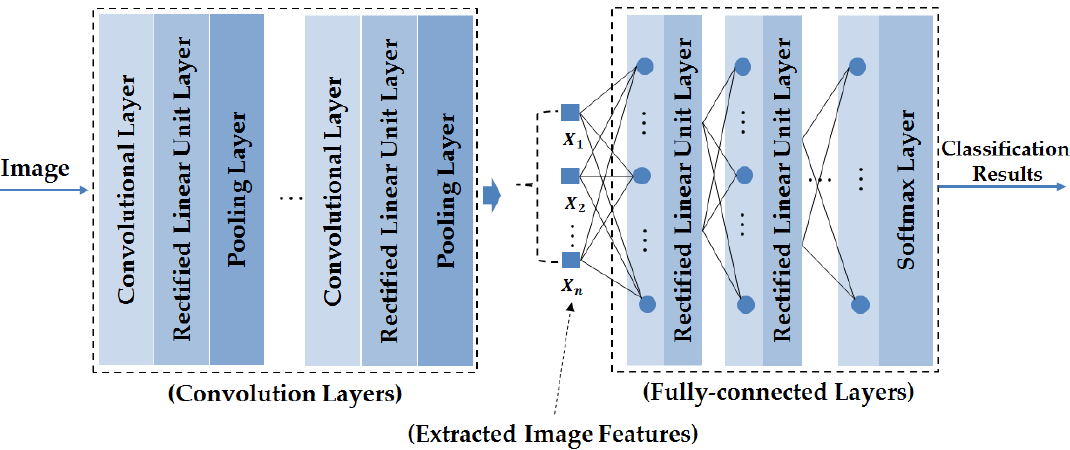
Figure 2. General structure of a CNN.